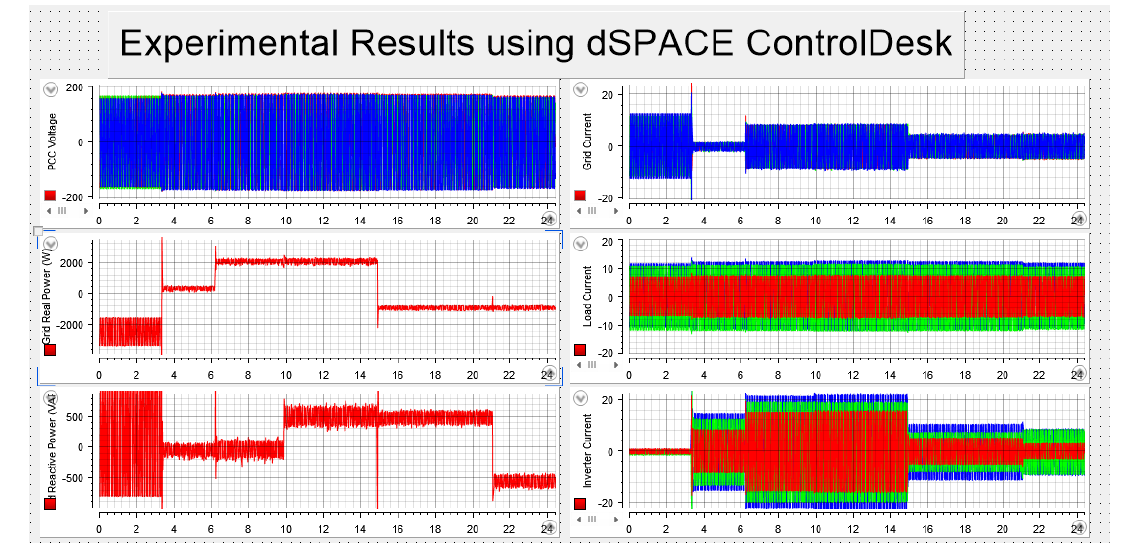
Figure 31. Hardware results of various real and reactive power values using dSPACE Controldesk under unbalanced grid